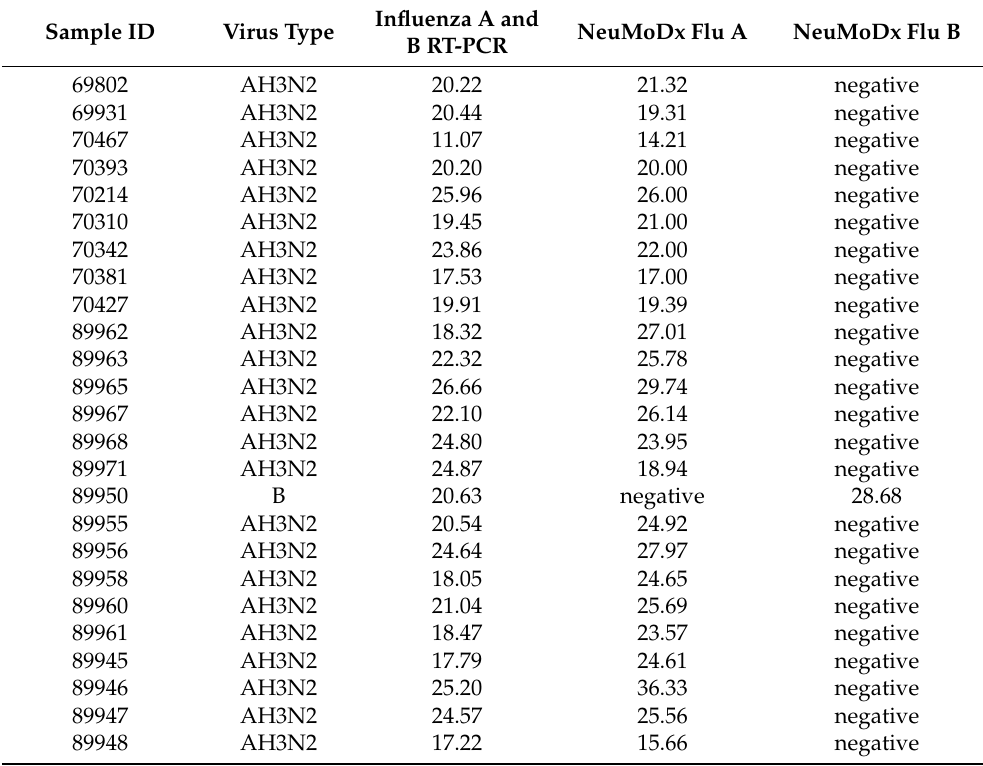
Table 1. Cycle threshold values of influenza A and B RT-PCR positive samples tested on the